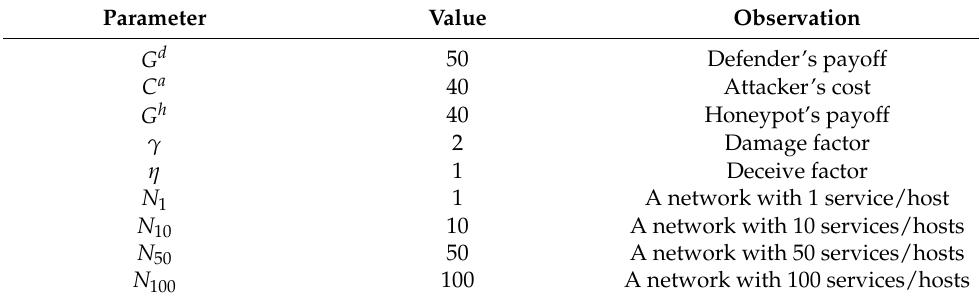
Table 3. Simulation parameters.